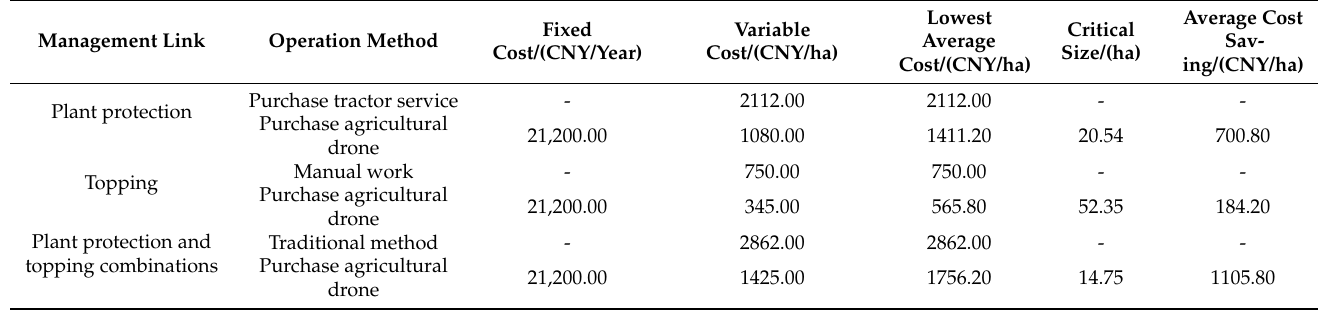
Table 4. The results of the economic evaluation of the traditional operation and purchase of agricul- tural drones for plant protection and topping